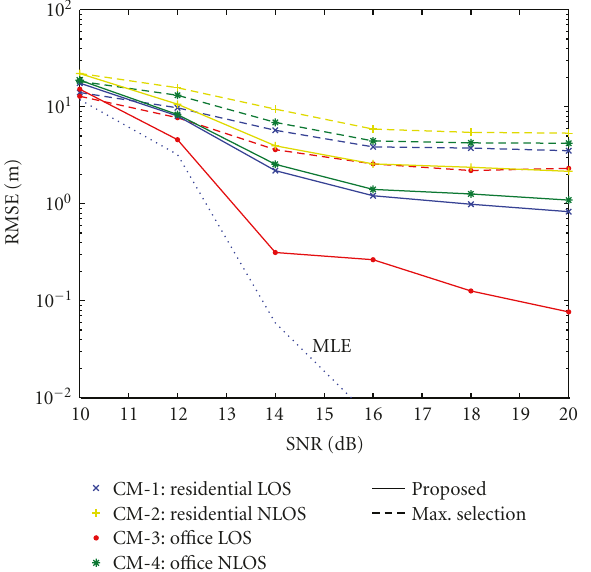
Figure 6: RMSE versus SNR for the proposed and the conventional maximum (peak) selection algorithms.